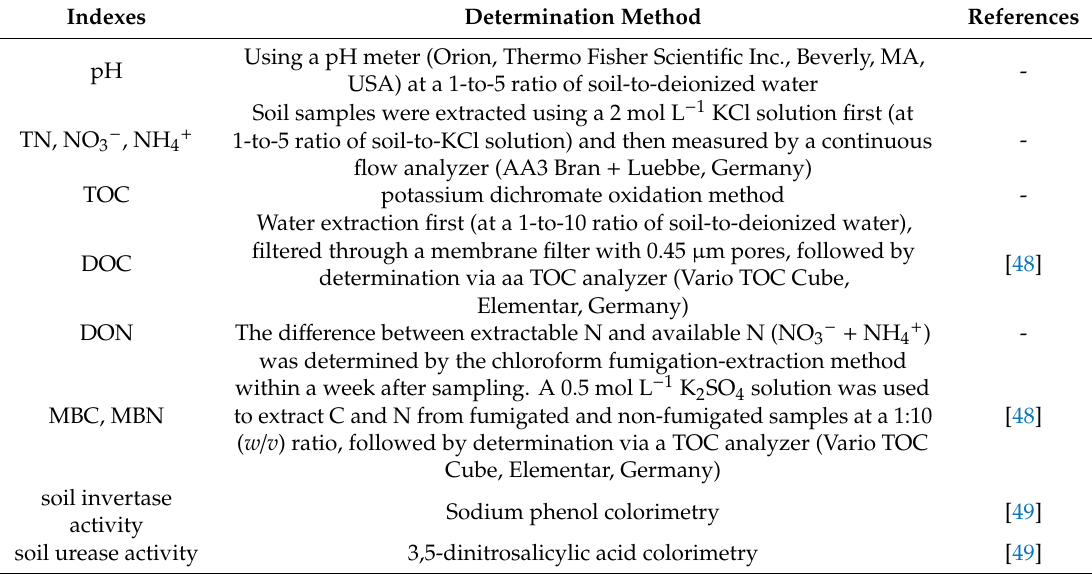
Table 1. Soil sample determination methods for the main